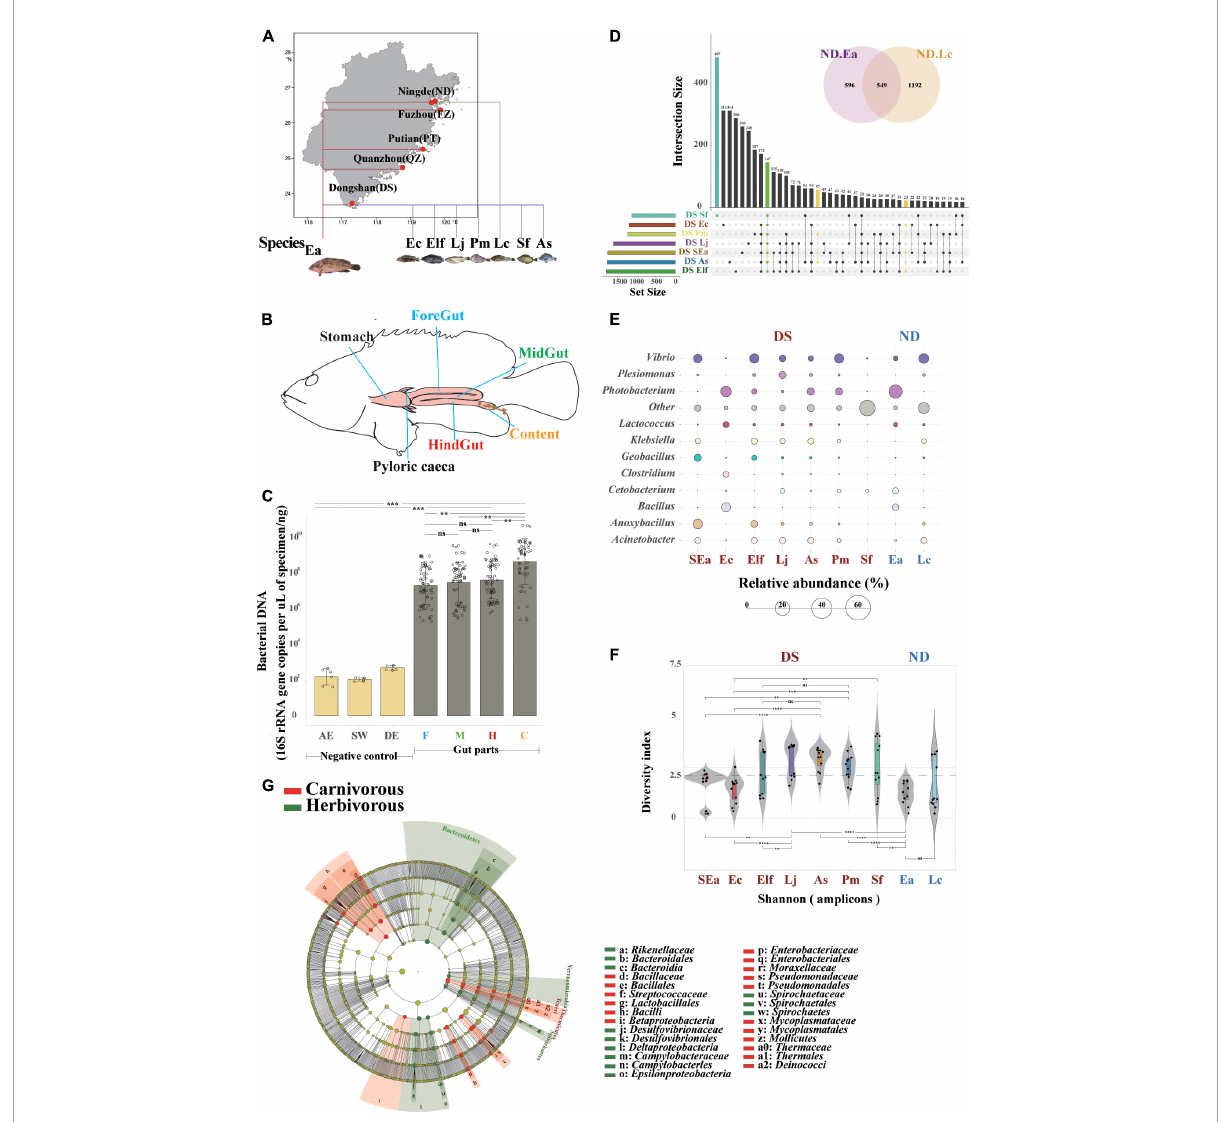
FIGURE1 Host genetics play more important roles in the evaluation of core microbes of different commercial fish in the same area. (A) Study area and sampling sites in Fujian Province (from south to north: DS, QZ, PT, FZ, and ND). (B) Spatial structure of the digestive tract of the marine commercial fish ( E. akaara ) and our four sampling sites (foregut, midgut, hindgut, and content). (C) Bacterial loads ( n = 68) were quantified by Q-PCR of the 16S ribosomal RNA gene. Differences were assessed by a two-tailed Student’s t -test. ** p ≤ 0.05; *** p ≤ 0.005; **** p ≤ 0.0005; and ns p > 0.05. AE, AE-buffer used in DNA extraction; SW, sterile water used in tissue homogenization; DE, DNA extraction controls (empty bead tubes); F, foregut; M, midgut; H, hindgut; and C, content. (D) UpSet and venn diagrams showing shared or unique OTUs among different fish species, both in DS and ND. (E) Balloon plot showing the abundance of the core specificity communities across different fish species both in DS and ND at the genus level. (F) α -Diversity comparison based on the Shannon diversity index, with ANOVA used to determine significant differences (** p ≤ 0.05; *** p ≤ 0.005; **** p ≤ 0.0005; and ns p > 0.05). The plots are a combination of violin plots, dot plots, and box plots, with the box plots showing the median and the 25 and 75% quantiles. (G) Cladogram generated from linear discriminant analysis (LDA) effect size (LEfSe) showing the relationship between taxon (the levels represent, from the inner to outer rings, phylum, class, order, family, and genus).